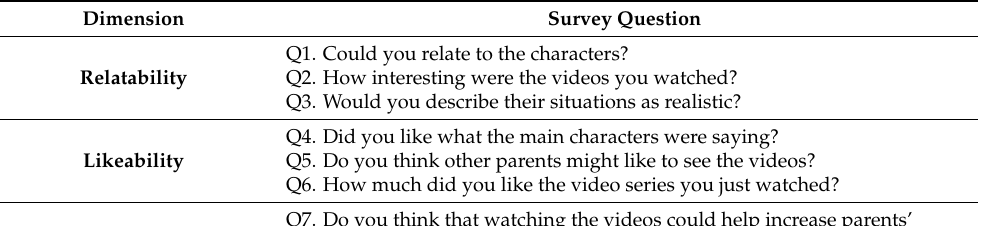
Table 1. Project Dimensions and Sample Survey